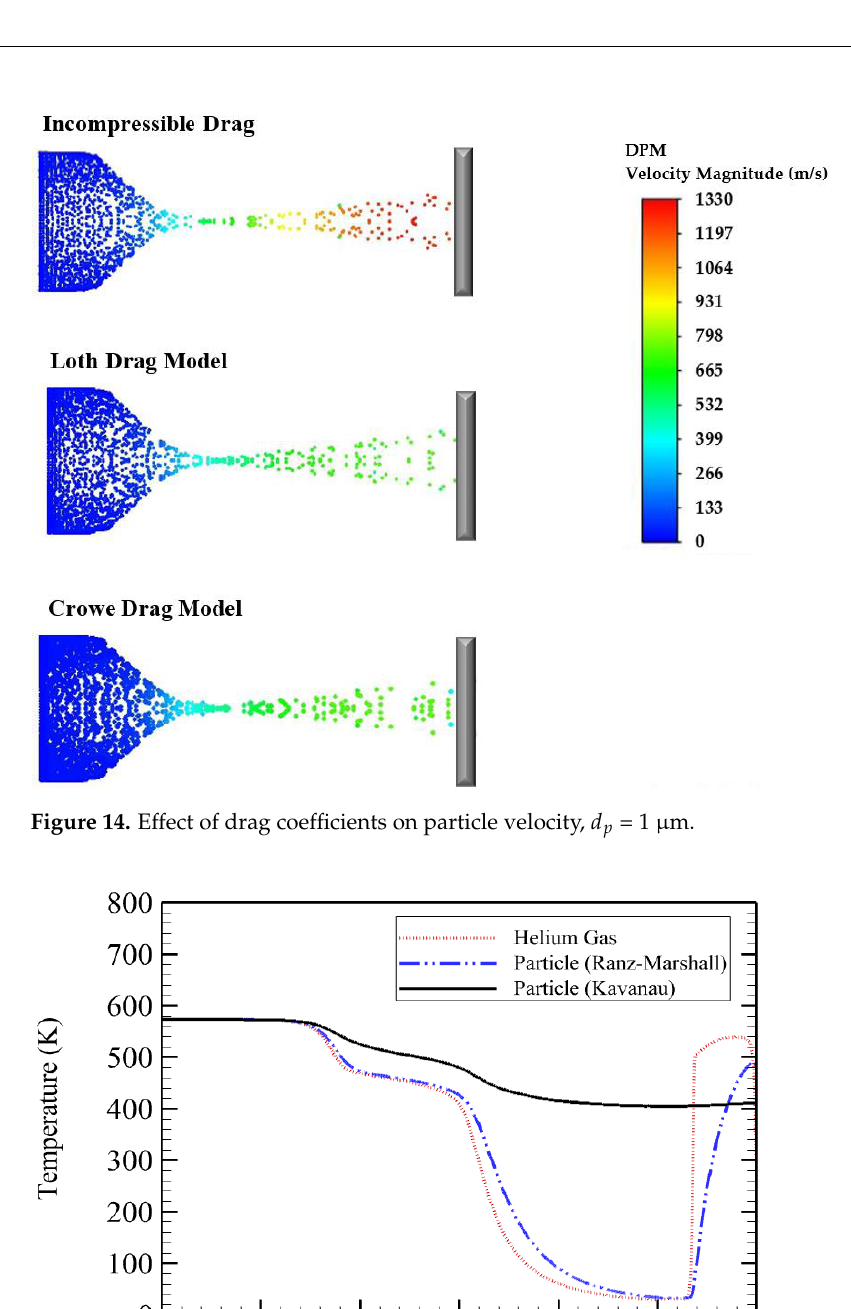
Figure 15. Effect of Nusselt number correlation on centerline particle temperature, 𝑑 𝑝 = 1 μm .